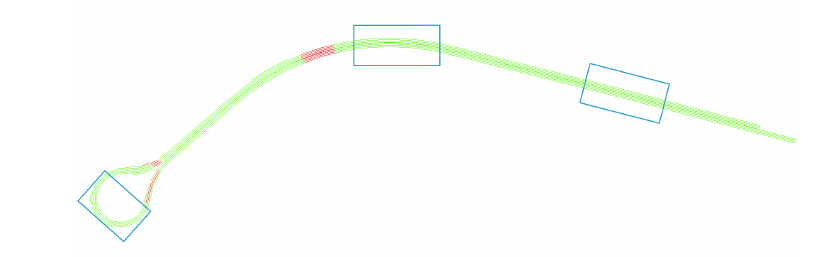
Figure 22. The overall mapping results.